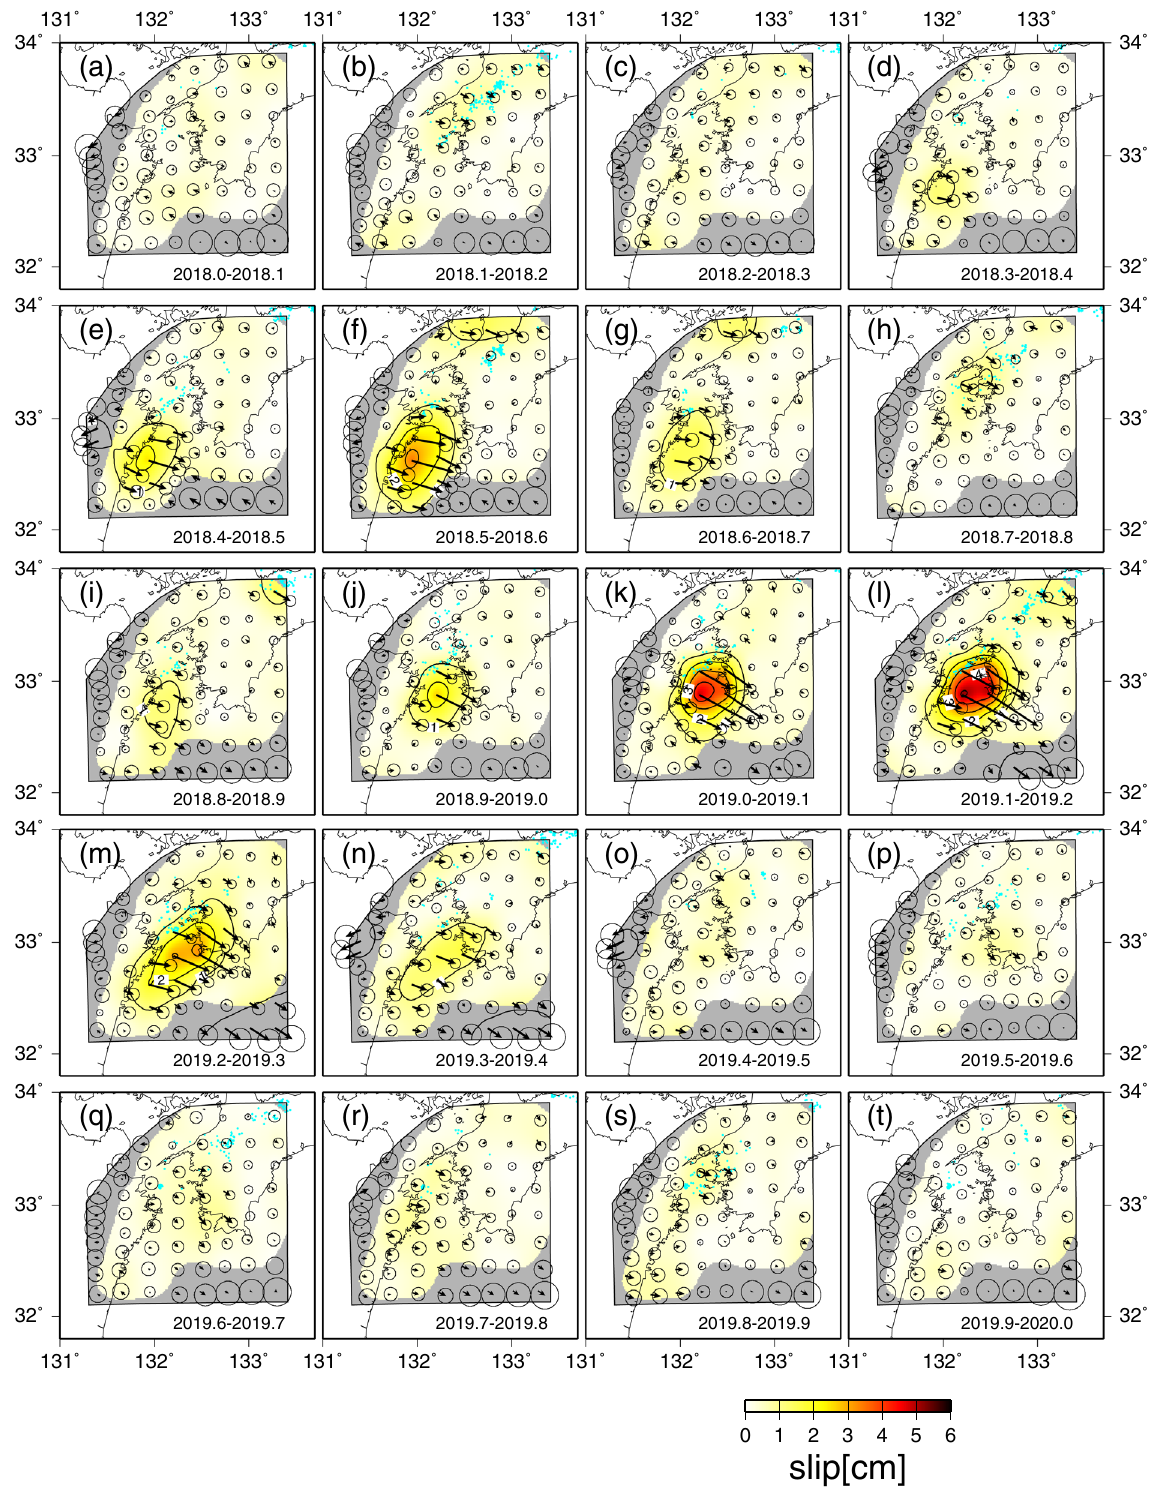
Figure 4. Slip distributions of the Bungo Channel L-SSE for the 0.1-year time step between 2018.0 and 2020.0. The arrows indicate the directions and amounts of the slip, and the circles at the tips of the arrows indicate the estimation errors of 1σ. The contour lines with yellowish colour show the amounts of slip with an interval of 1 cm. Areas with a resolution of less than 0.15 are masked in grey. The light blue dots indicate the epicentres of tectonic tremors that occurred during each period. We used hypocenter catalogue of tectonic tremors provided by National Research Institute for Earth Science and Disaster Resilience. Each 0.1-year time period is shown in each panel. The map was created by using the Generic Mapping Tools (GMT) 15 (version: GMT 4.5.7, URL link: https:// www. gener ic- mappi ng- tools. org/ downl